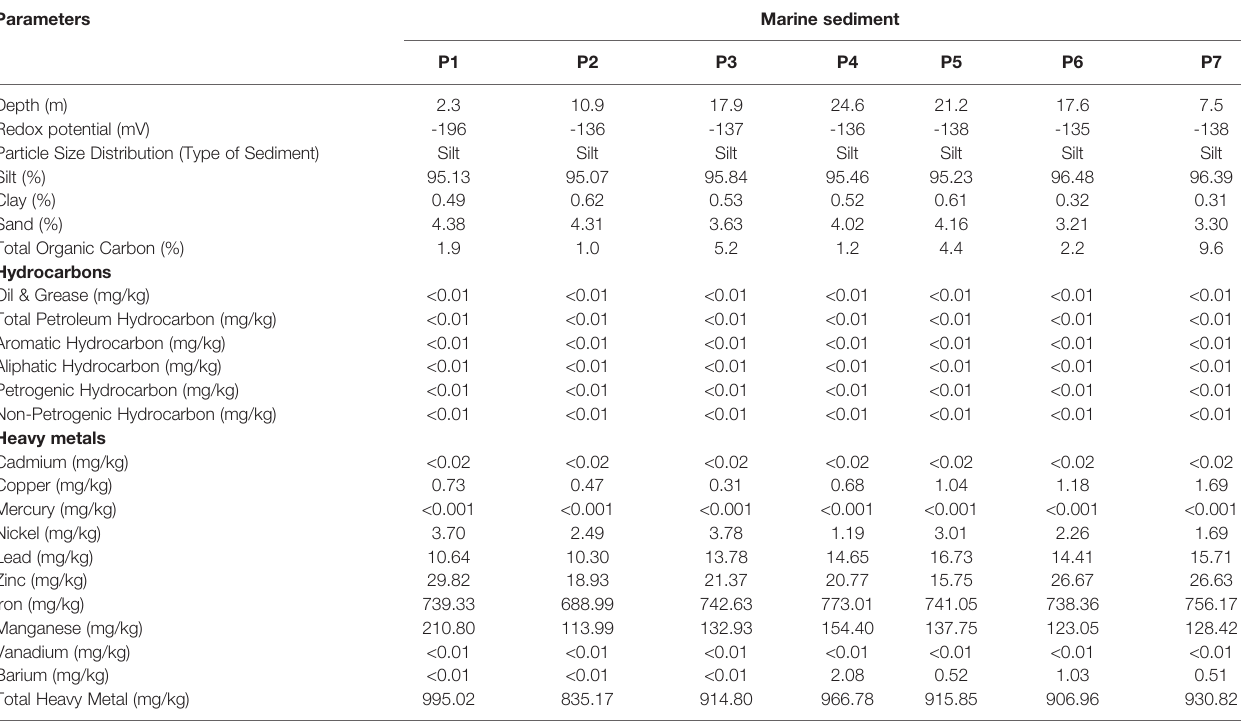
TABLE 3 | Physical properties of marine sediment sampling sites (existing site and proposed site) at straits of Kukup Straits, Johor, Malaysia.